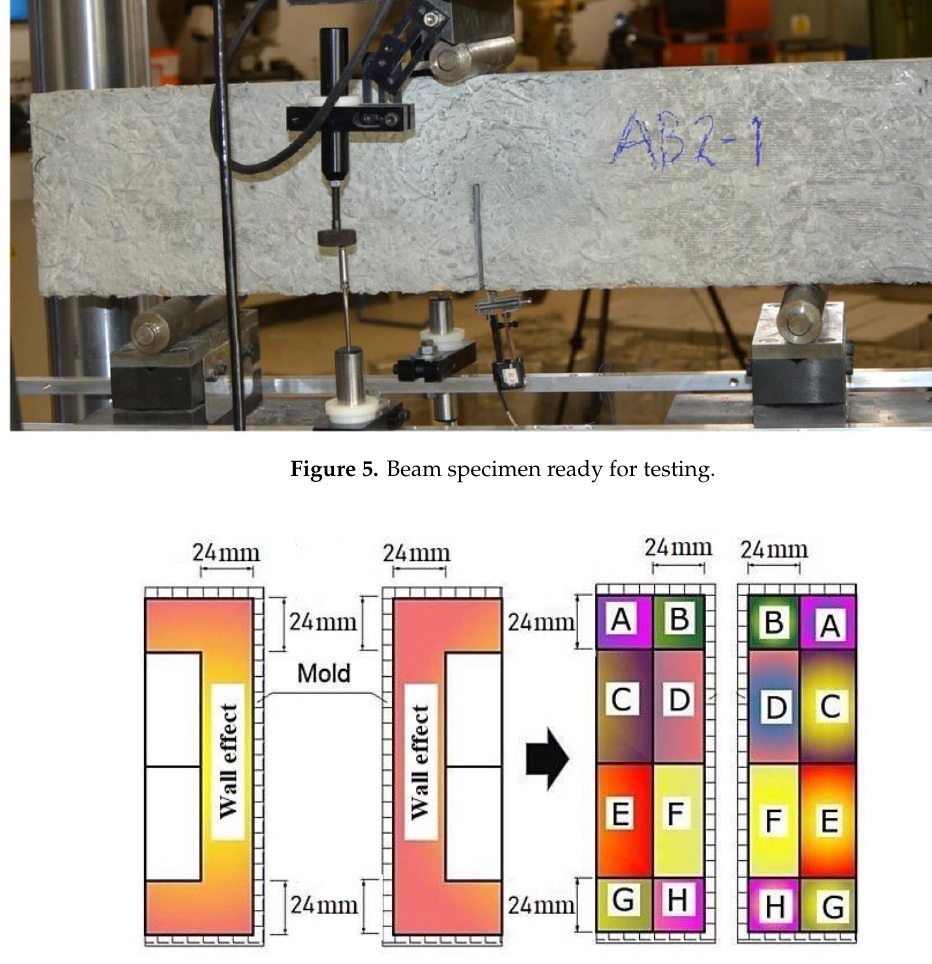
Figure 5. Beam specimen ready for testing.